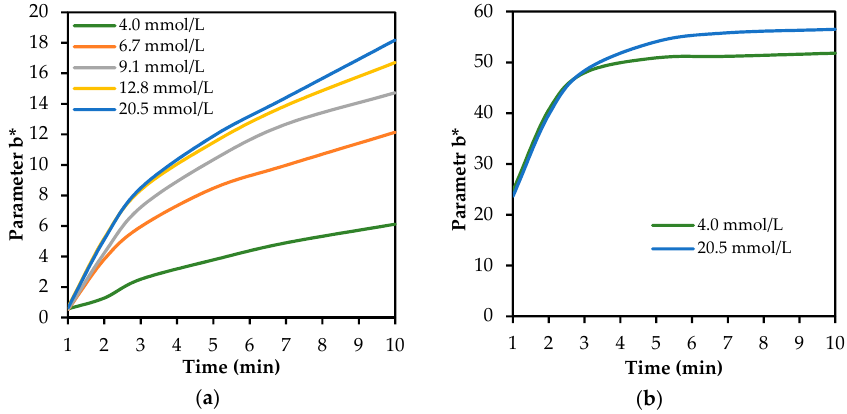
Figure 6. The influence of the ATChI substrate concentration on the change of colour in a fabric impregnated with AChE: ( a ) inhibited within 1 min with 10 µg/mL solution of physostigmine and ( b ) in the blank test.